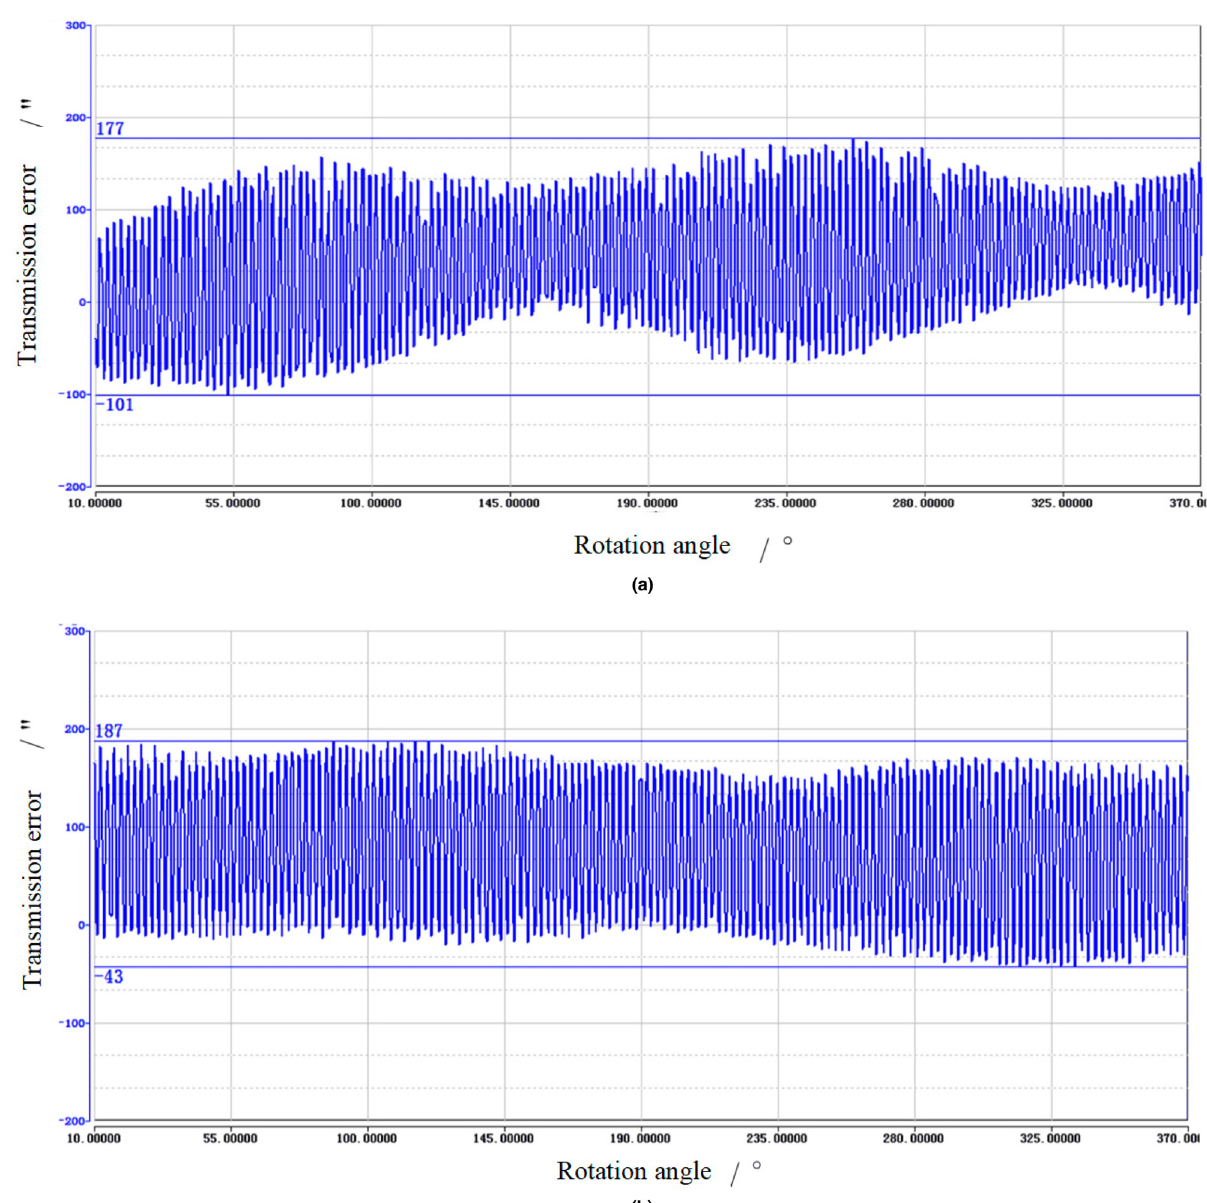
Figure 15: Transmission error of HD: ( a ) before optimization and ( b ) after